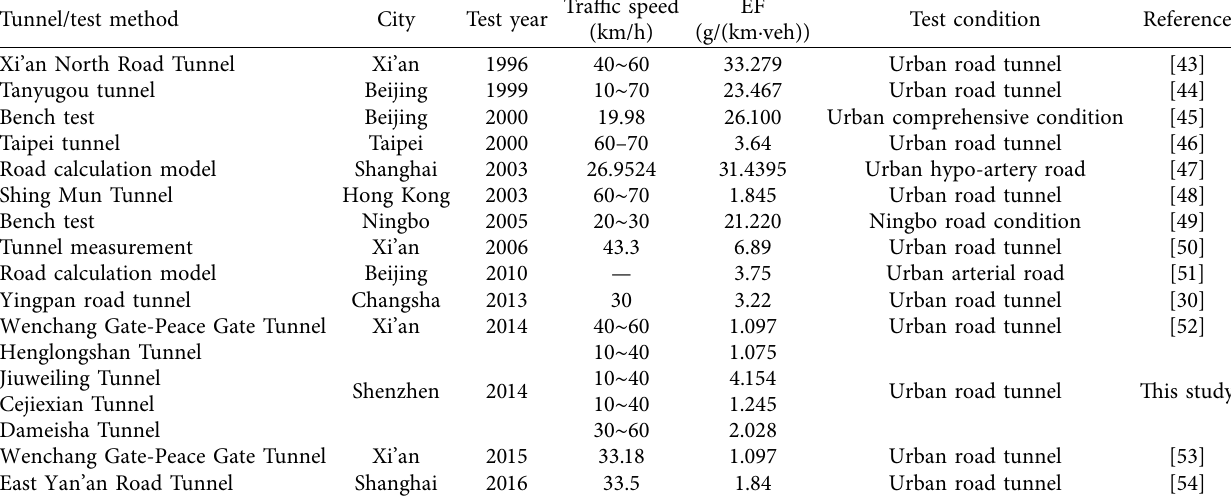
Table 7: Average CO emission factors of motor vehicles (mixed traffic) in different regions of